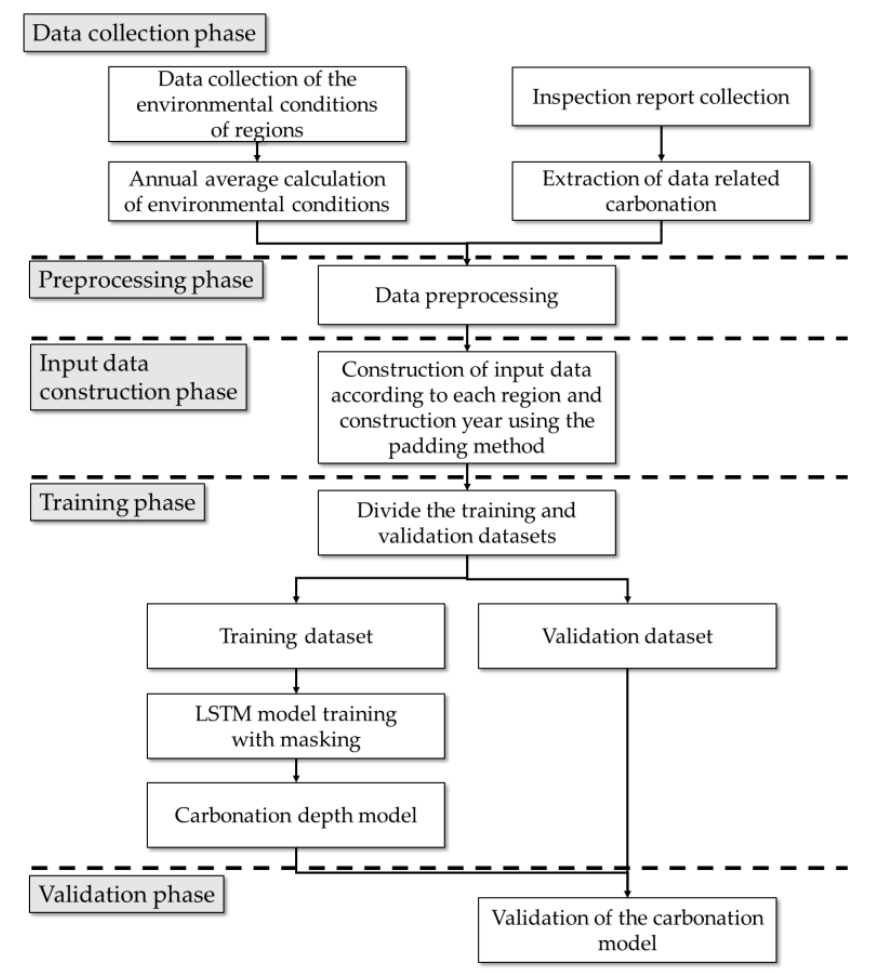
Figure 6. Methodology for generating a carbonation model for actual bridges.